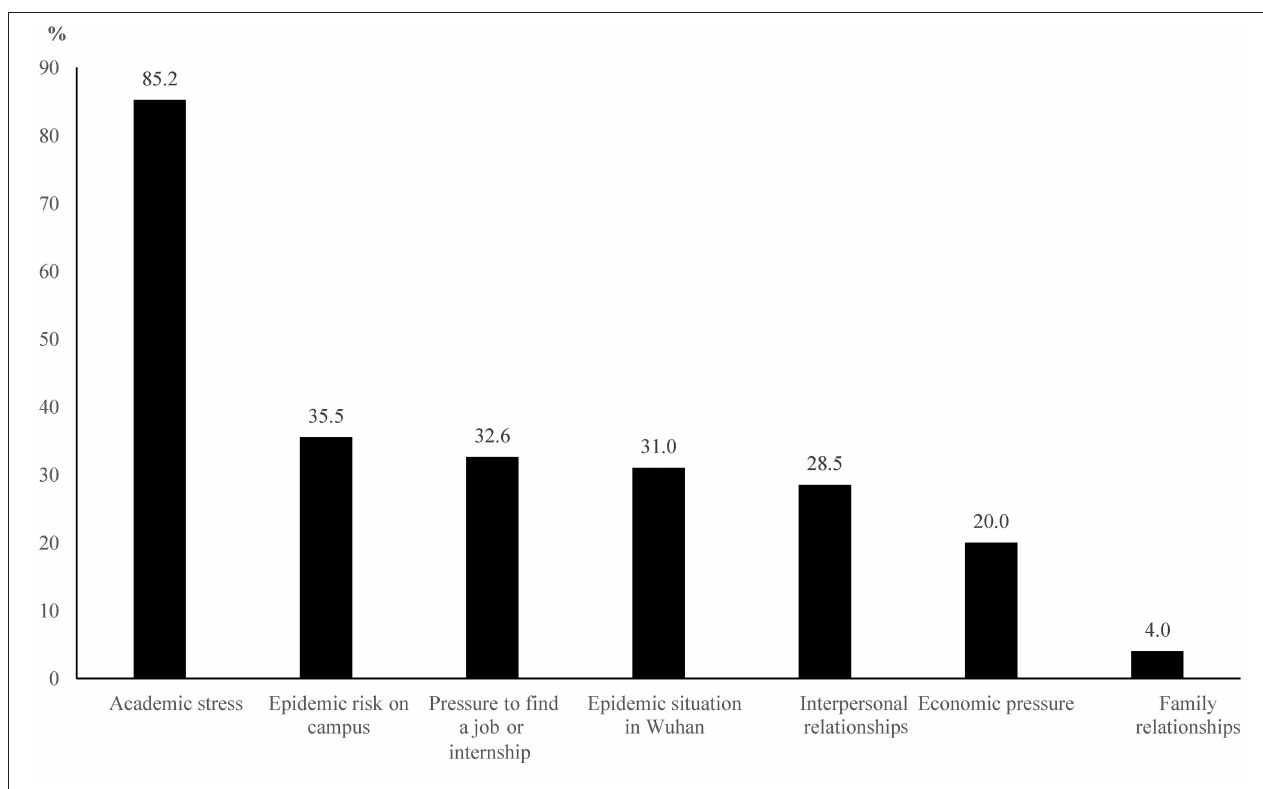
FIGURE 1 | The reasons for anxiety in the face of returning to school among college students in Wuhan, China during the normalization stage of COVID-19 prevention and control ( n = 1,192).